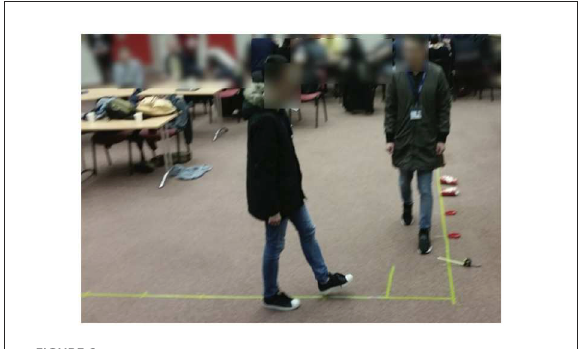
FIGURE6 Lidar tracked human subject pair playing continuous Sequential Chicken.